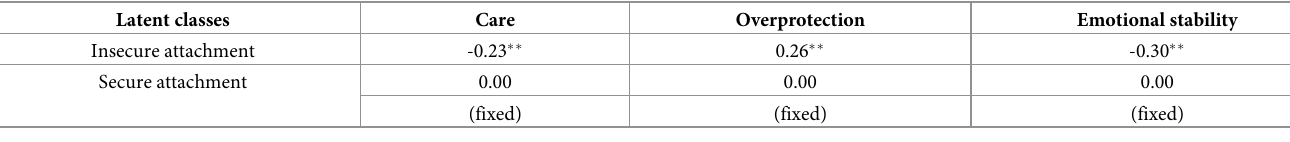
Table 5. Means for each class in care, overprotection and emotional